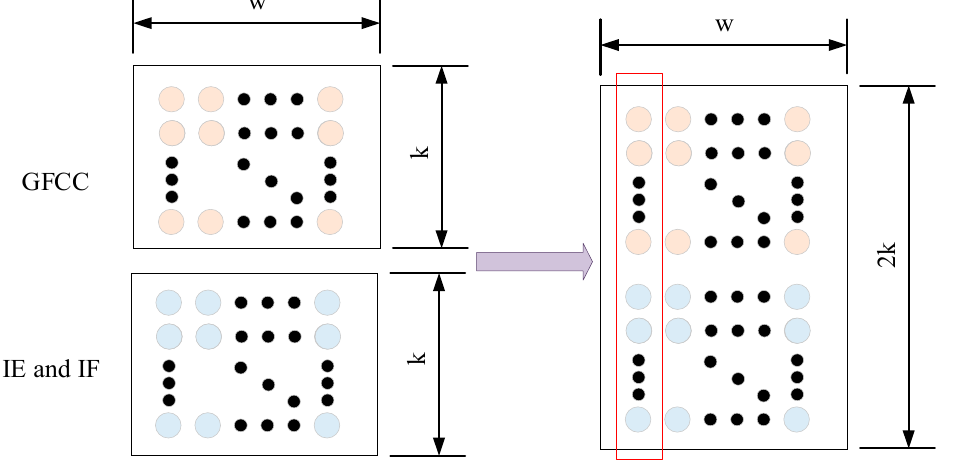
Figure 8. Fusion feature matrix structure.